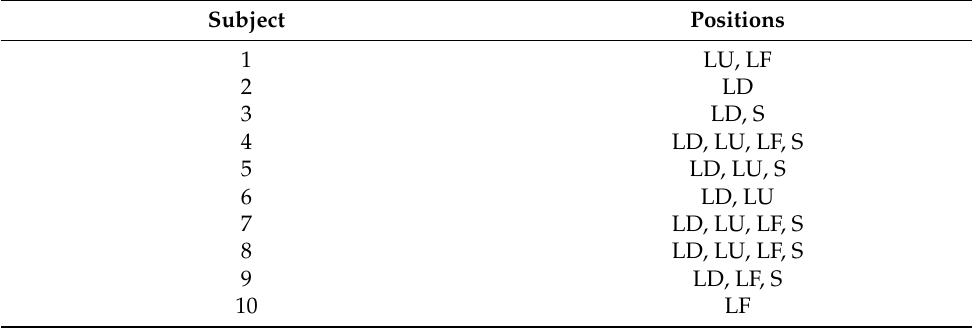
Table 1. Positions for each subject of the